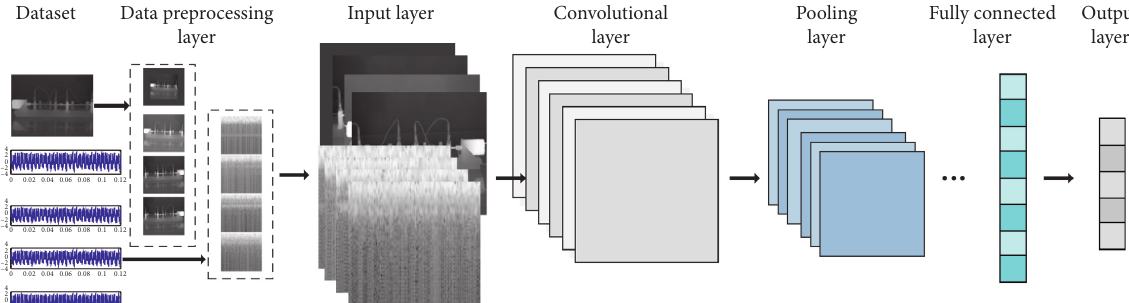
Figure 5: The structure of the multichannel CNN network.